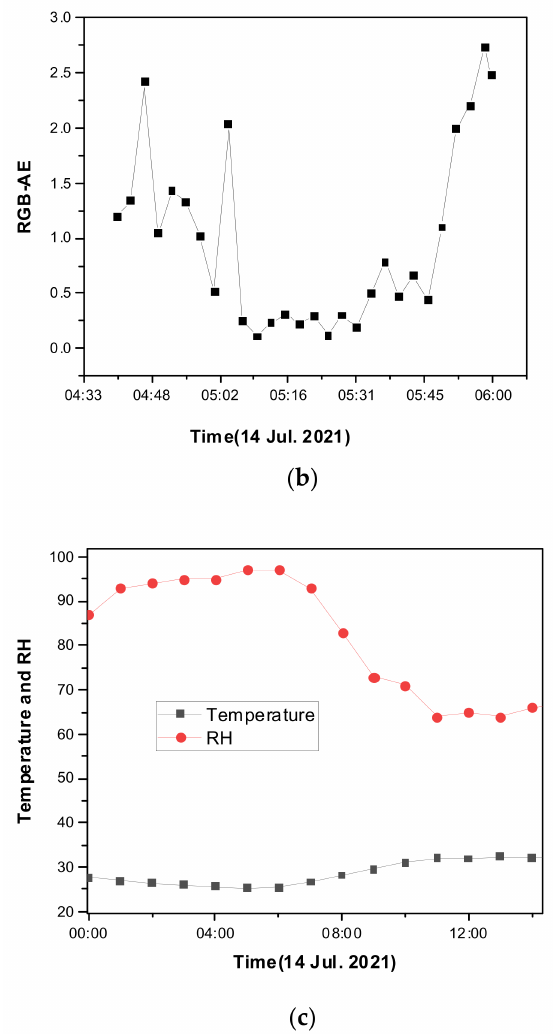
Figure 11. Aerosol extinction and the RGB-AE characteristics based on the changes in the hu- midity/temperature measured in early morning twilight conditions: ( a ) extinction coefficients, ( b ) RGB-AE, and ( c ) humidity and